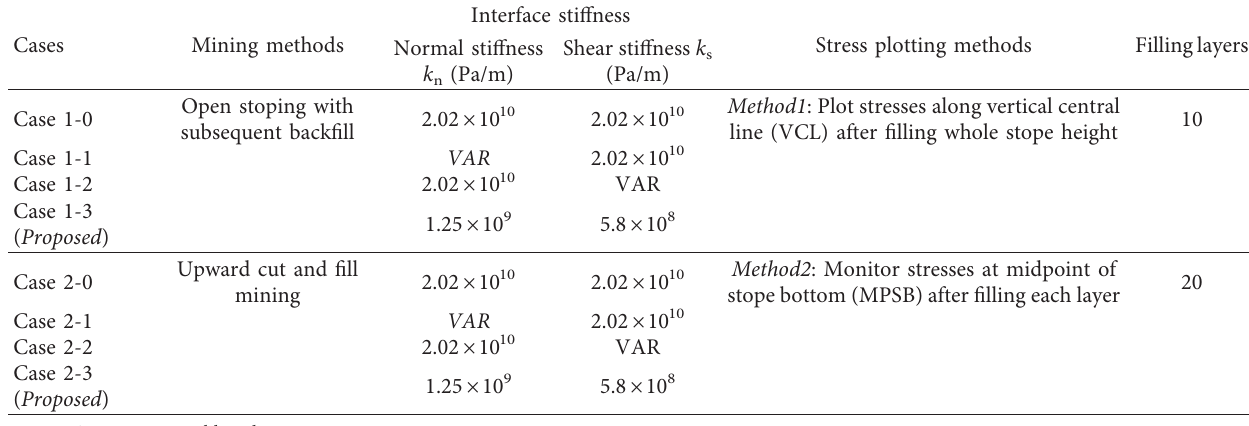
Table 2: Numerical simulation programs for stresses analyses in backfilled stopes.